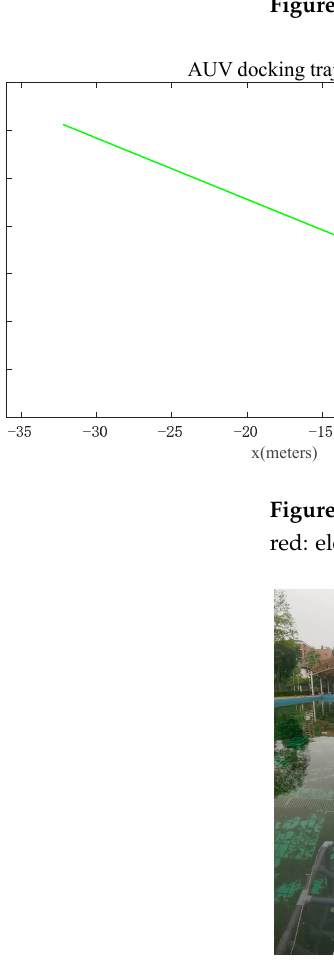
Figure 18. The DS and AUV with an electromagnetic guidance module in the docking experiment.